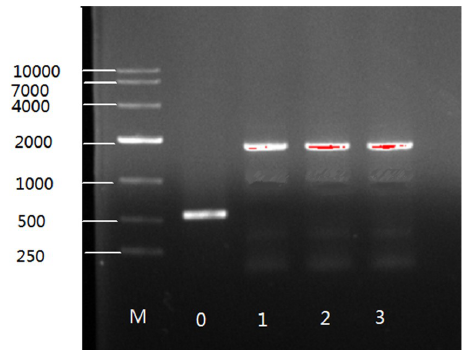
Figure 2. PCR amplification of genome of control and recombinant strains. Band 0 representing the control strain and 1,2,3 showing the recombinant strains.